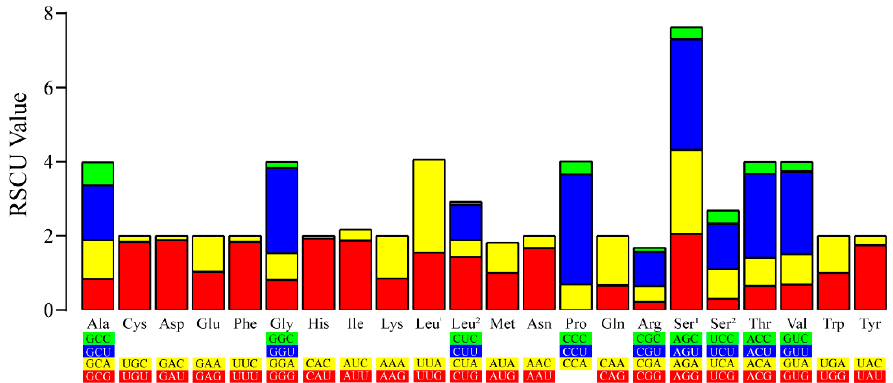
Figure 3. Relative synonymous codon usage (RSCU) values of the obtained mitogenomes. RSCU values are represented on the y-axis, and codons for the amino acids of the Onchocercidae family are represented on the x-axis.